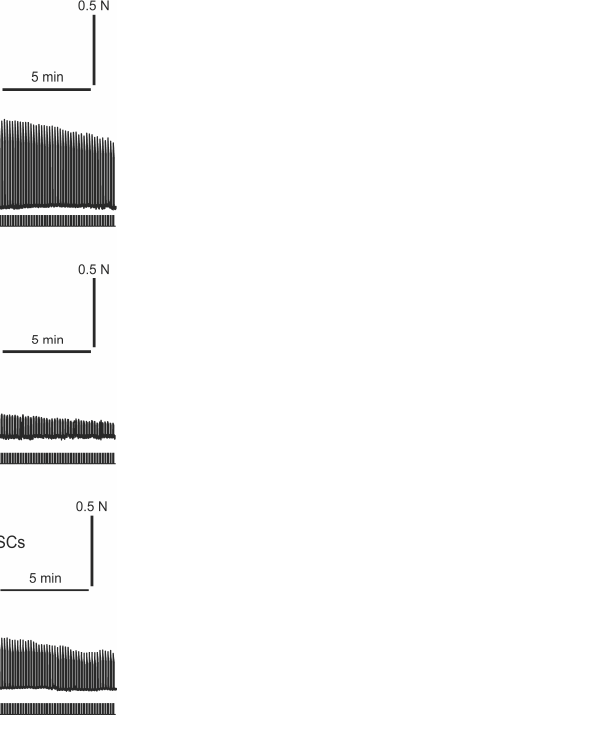
Figure 1. Examples of registration protocol of the triceps surae muscle contractions force of one Control animal, one mouse with peripheral neuropathy (PN) and one treated animal with peripheral neuropathy (PN+AD-MSCs). N—muscle force (Newton), st—stimulation mark.